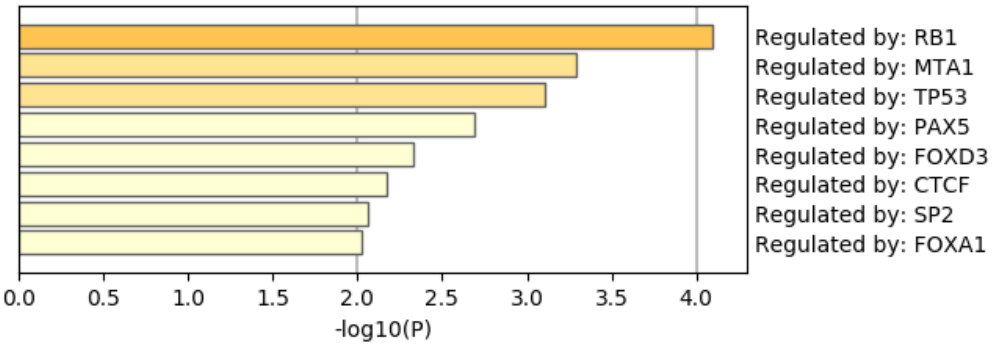
Figure 14. Summary of enrichment of the TRRUST category of Metascape when 1267 protein-coding genes included in 1447 genomic regions selected by RF are